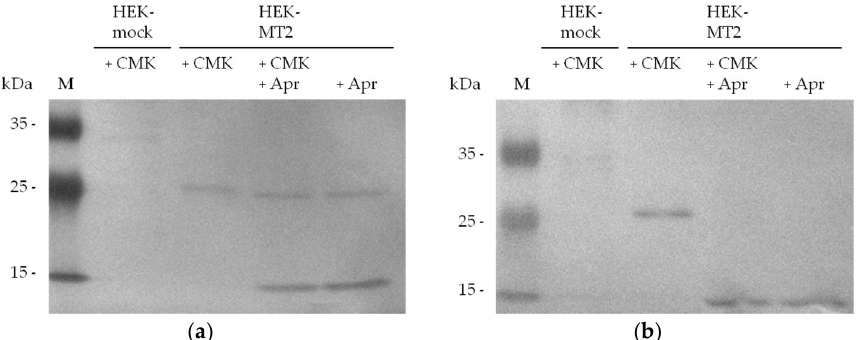
Figure 6. MT-2 detection by biotin-RQRR-CMK after treatment of 30 µg HEK cell supernatant with 50 µM aprotinin for 2 h before probe treatment (5 µM, 30 min): ( a ) Detection of MT-2 by an anti-myc antibody; ( b ) Detection of MT-2 by biotin-RQRR-CMK after incubation with Strep-Tactin/AP conjugate.